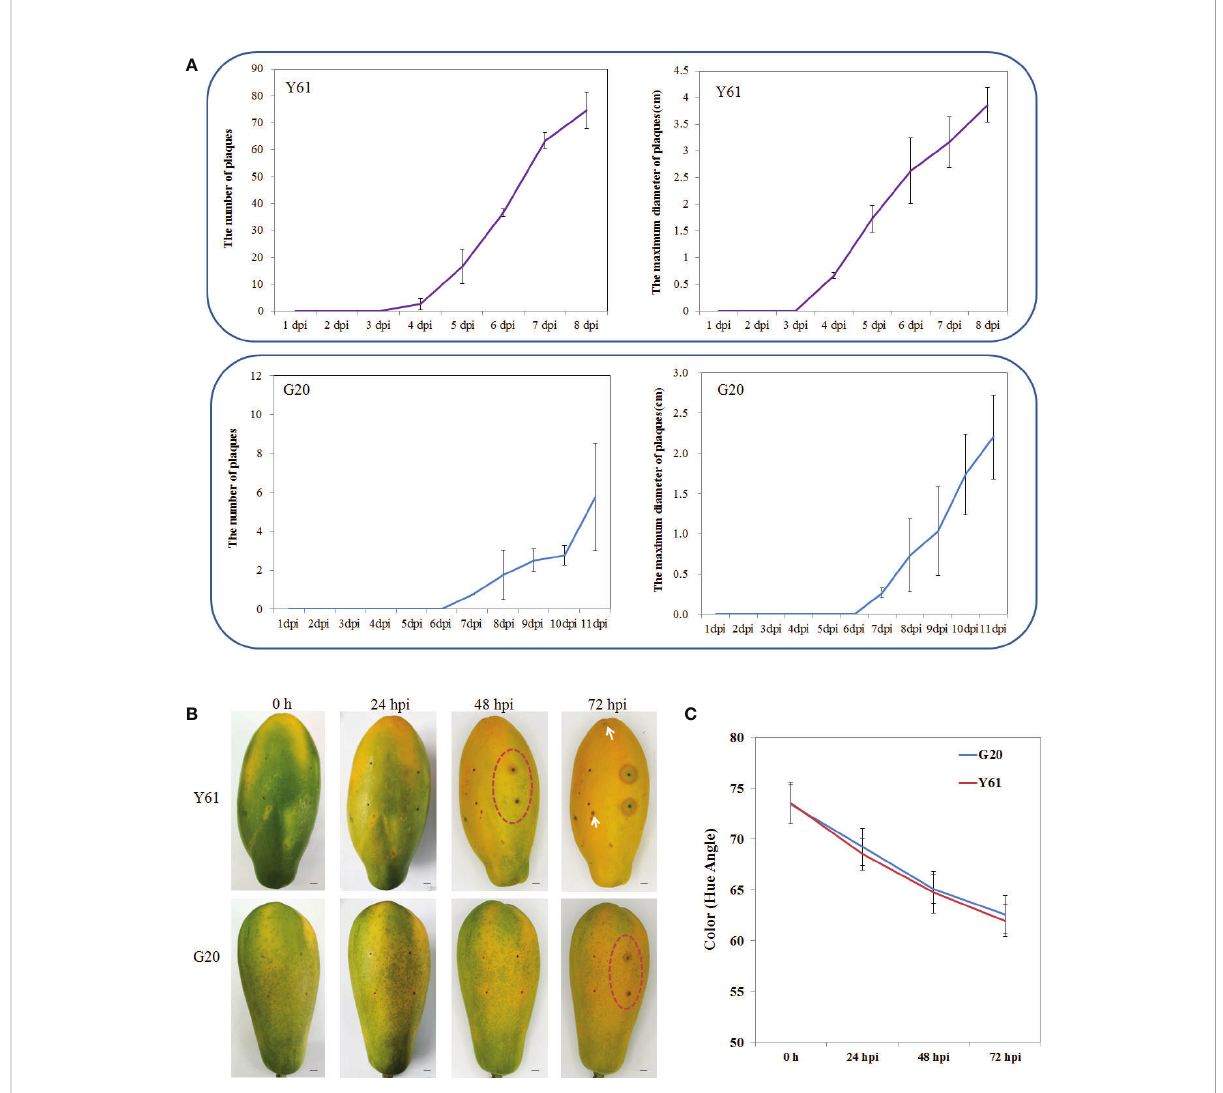
FIGURE 1 The difference of anthracnose tolerance between Y61 and G20 postharvest fruits after inoculated with C. brevisporum in vitro . (A) Statistical results of spray inoculation assay. Top, statistical results of the number and maximum diameter of anthracnose lesion plaques in Y61 from 1 to 8 dpi; bottom, statistical results of the number and maximum diameter of anthracnose lesion plaques in G20 from 1 to 11 dpi. (B) Results of needle puncturing inoculation assay. Each fruit was inoculated with four spots; two spots on the left were inoculated with sterile water as control, and the right was inoculated with C. brevisporum . The inoculation point in the red circle indicates the initial point of the anthracnose lesion plaque. The white arrow indicates the diffused lesion plaque outside the inoculation point in Y61. Bars=1cm. (C) . The fruits color development (angular hue) of Y61 and G20 at 0, 24, 48 and 72